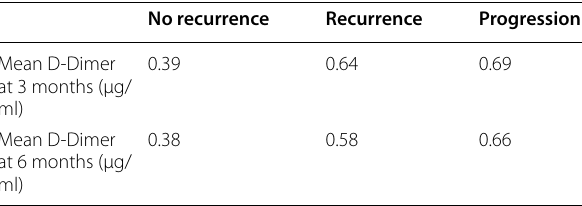
Table 5 Comparison between mean plasma D-dimer levels with recurrence and progression at 3 and 6 months